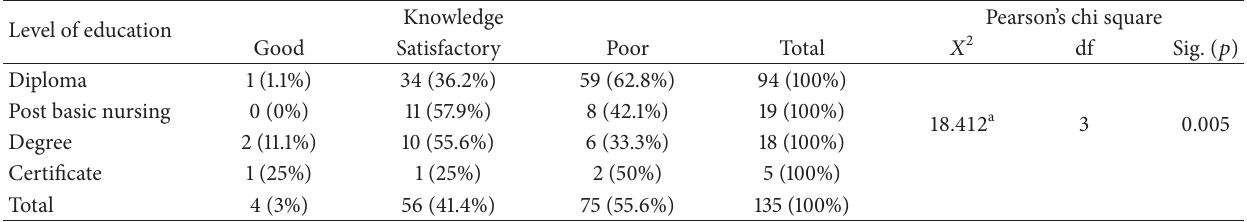
Table 1: Pearson’s chi square association between knowledge and level of education (𝑛 = 135) . Level of education